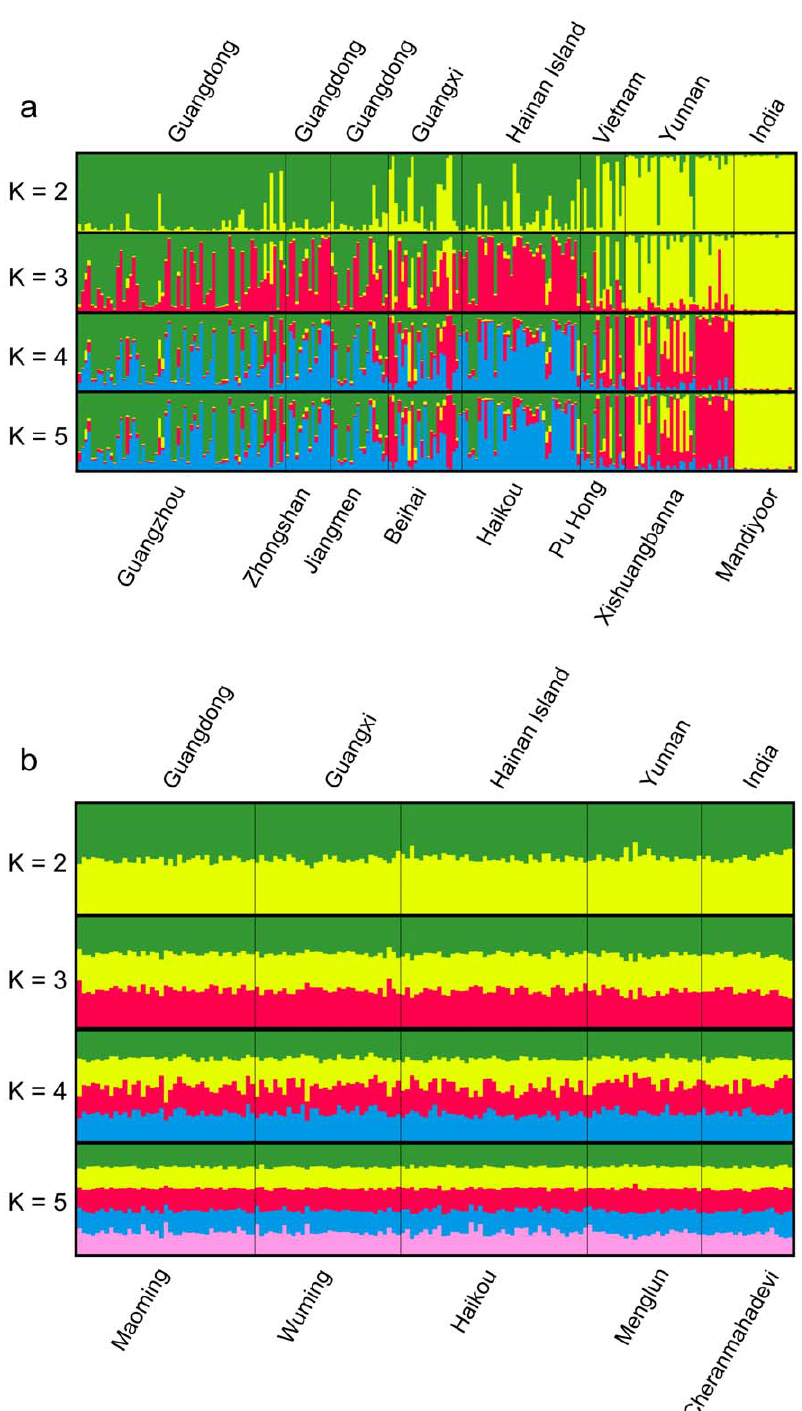
Figure 2. Clustering analysis for Cynopterussphinx and Rousettusleschenaulti. Clustering analysis for a) eight Cynopterus sphinx populations and b) five Rousettus leschenaulti populations. The different colors represent the proportional membership of individuals from each locality to a given cluster, undertaken for increasing numbers of clusters (K) using STRUCTURE.